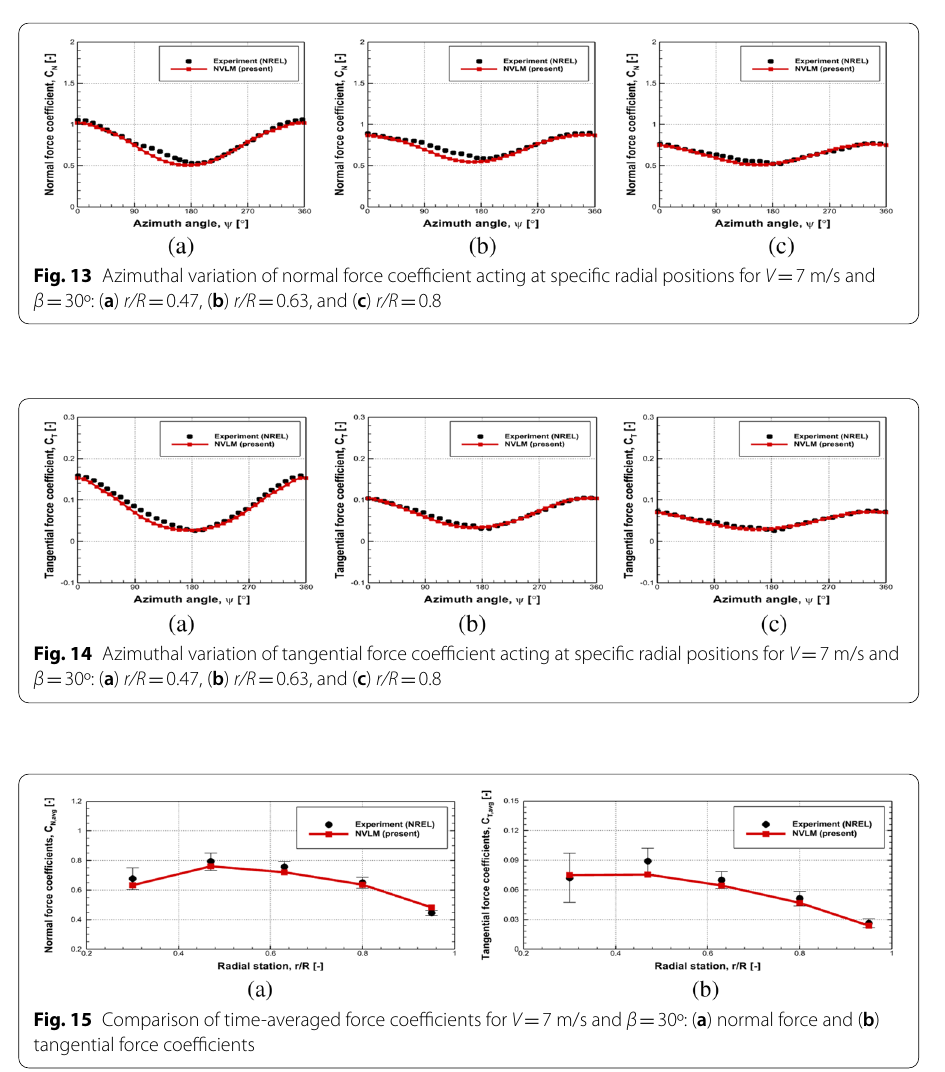
7 m/s and β 30º: ( a ) normal force and ( b ) = =